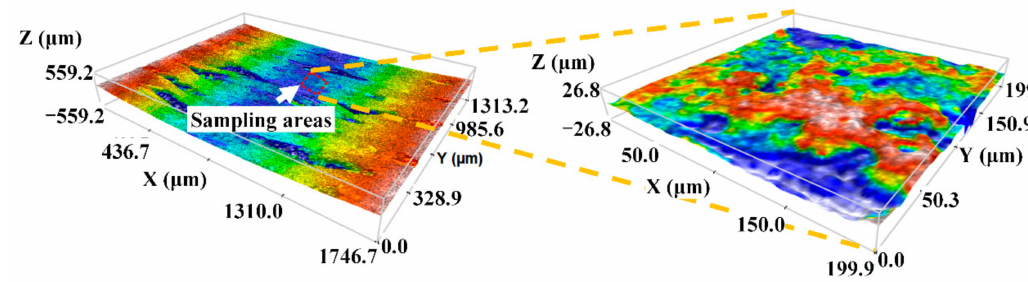
Figure 11. Sa sampling method.